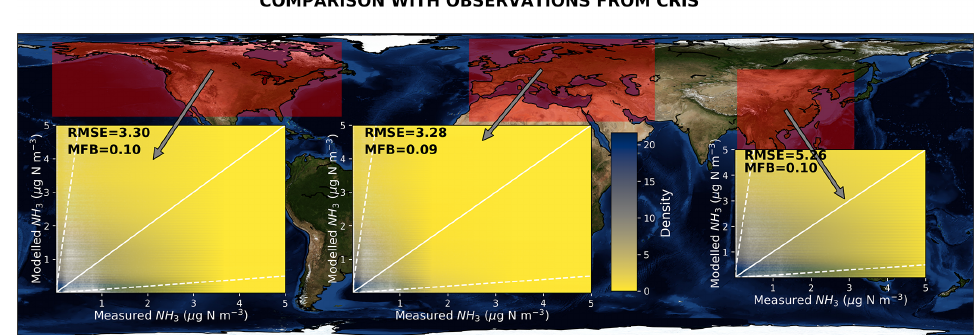
Figure 9. Kernel density estimation (KDE) of the probability density function (PDF) of modelled versus CrIS concentrations of ammonia in a non-parametric way. Modelled concentrations are results of simulations using NE emissions datasets for the period 2012–2017, for which CrIS data were available. The comparison is shown for North America, Europe and Southeastern Asia.